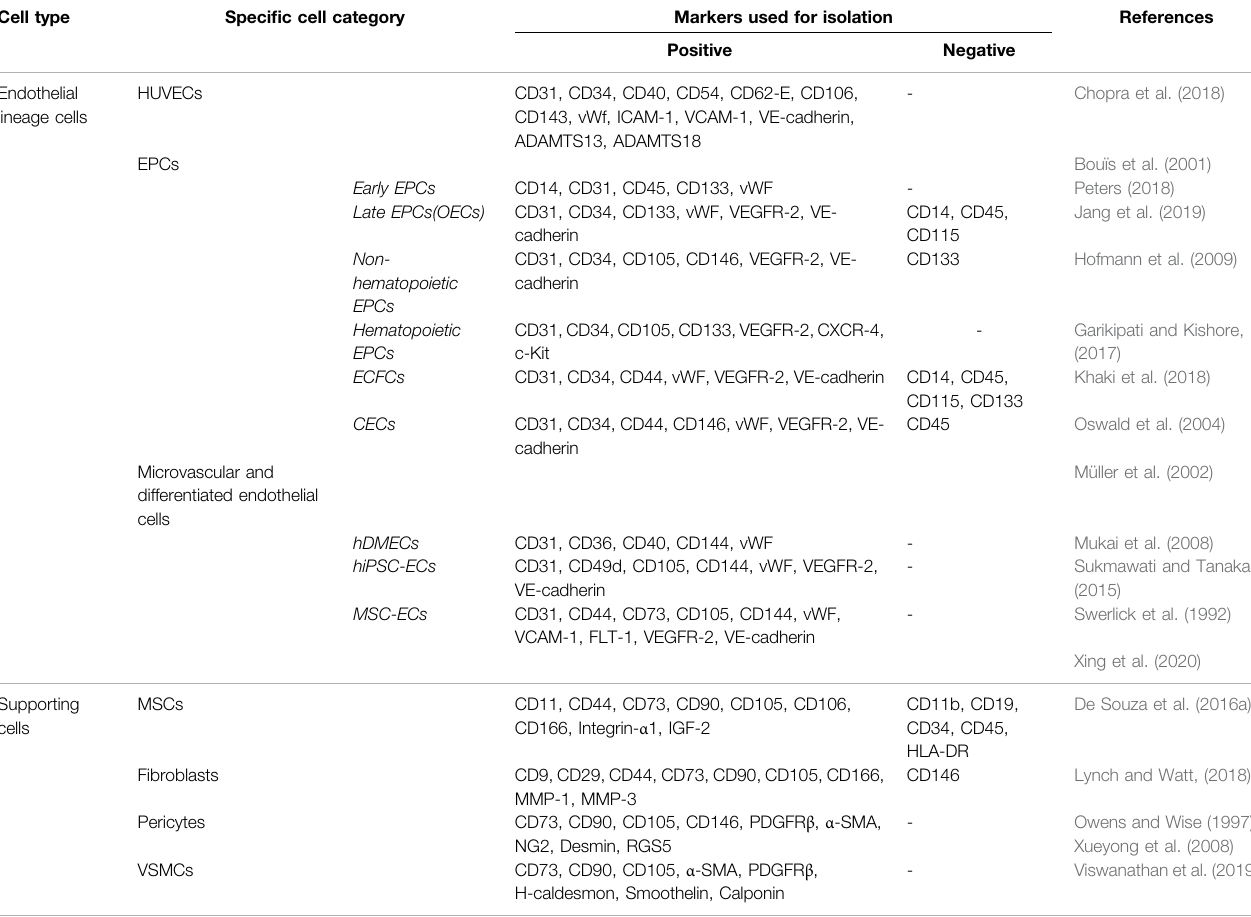
TABLE 1 | Common markers used for isolation of endothelial cells and supporting